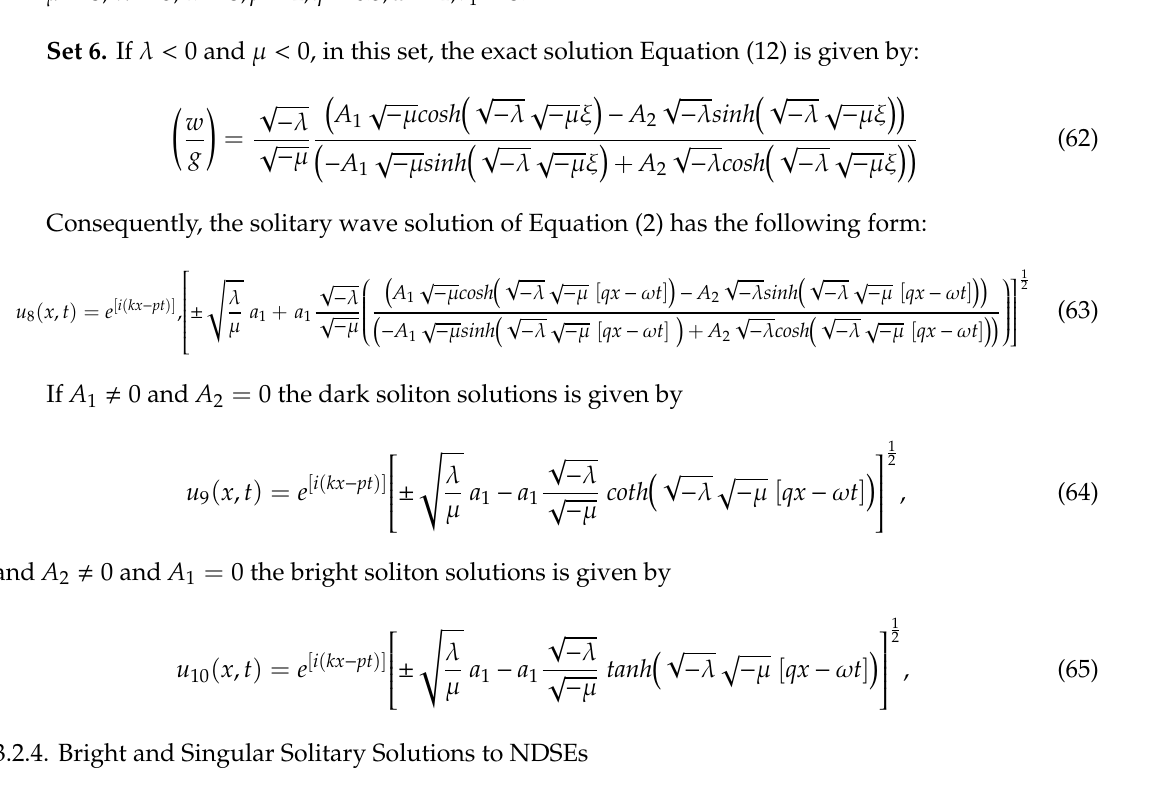
Figure 6. Singular periodic wave solution (6) of Equation (2) and its projection at t = 0 when µ = 3, λ = 5, k = 3, p = 2, q = 0.5, ω = 1, r 1 = 3 .